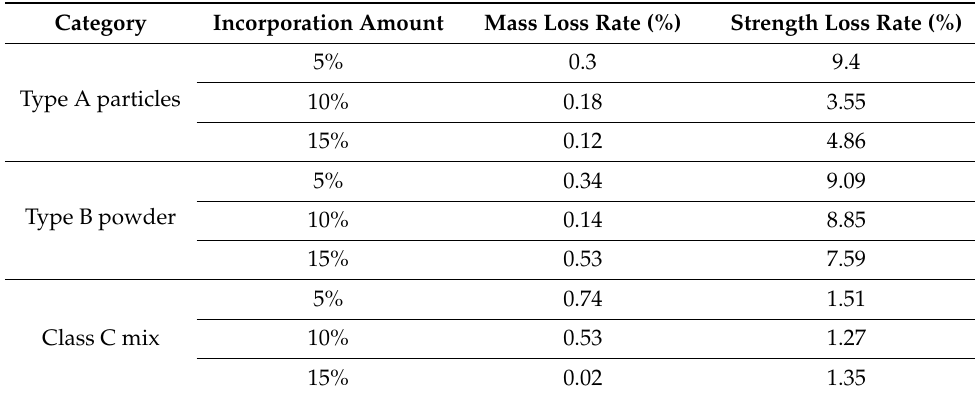
Table 4. Mass loss rate and strength loss rate of ER concrete.